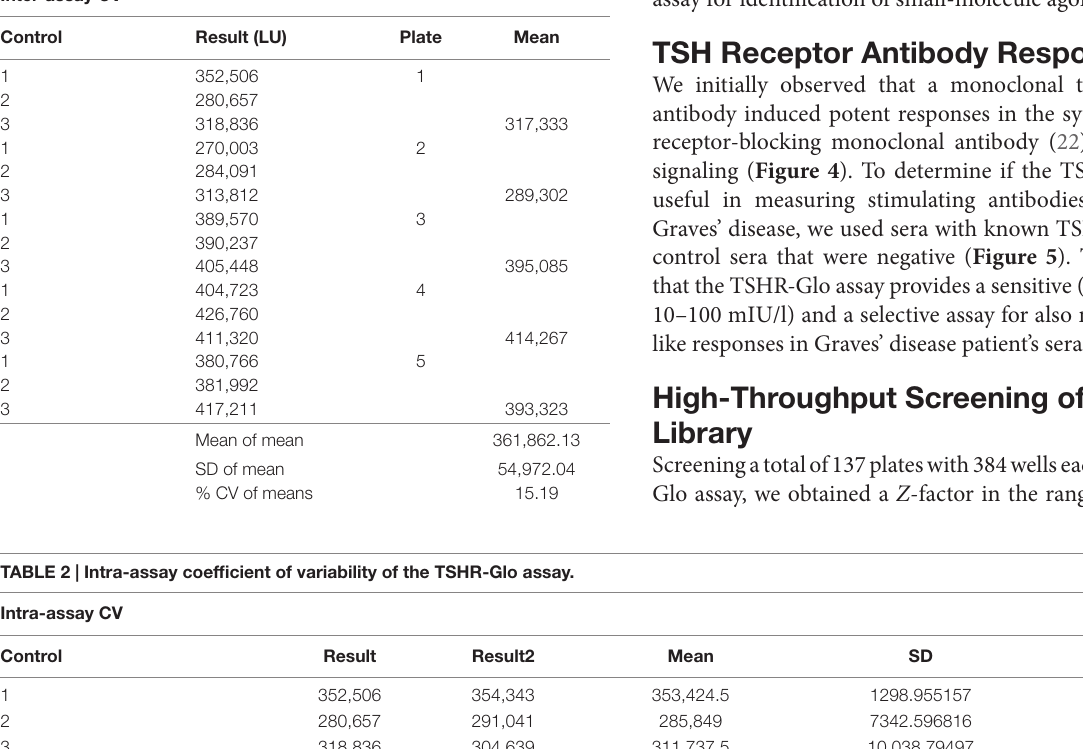
tABLe 1 | Inter-assay coefficient of variability of the tshR-Glo assay. Inter-assay CV Control